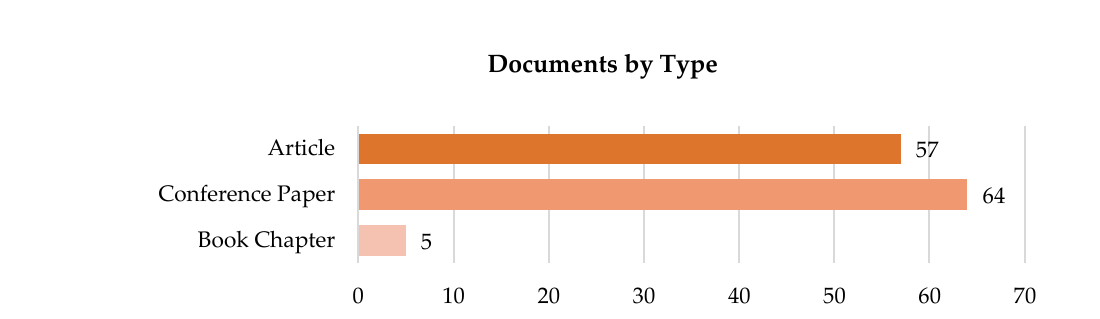
Figure 7. Distribution of documents by type according to the classification of the Scopus database.